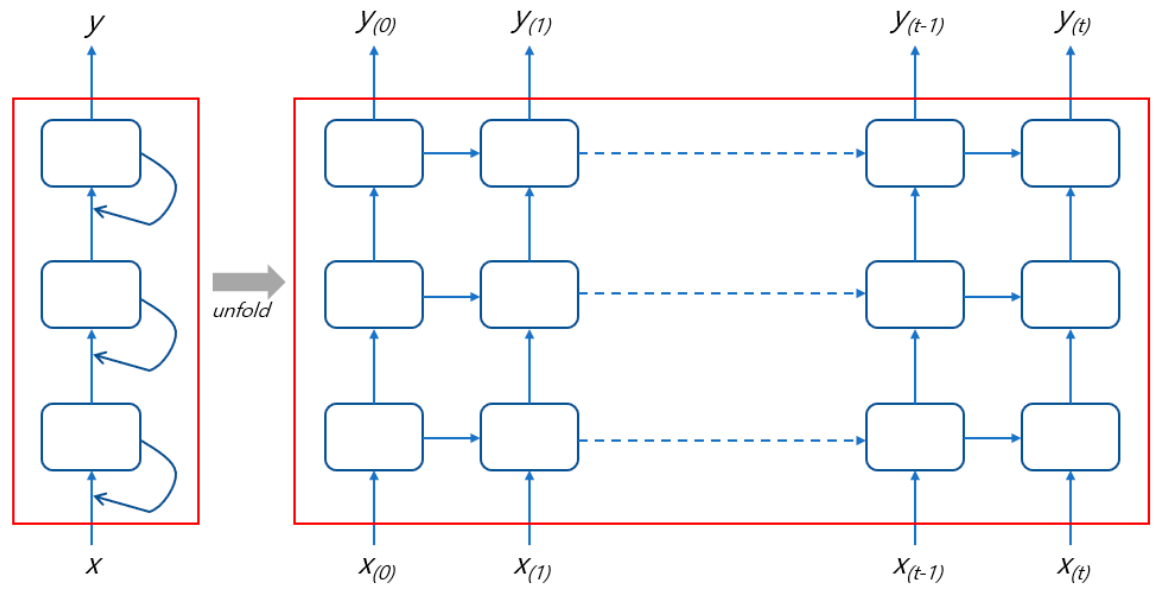
Figure 2. General recurrent neural network architecture.